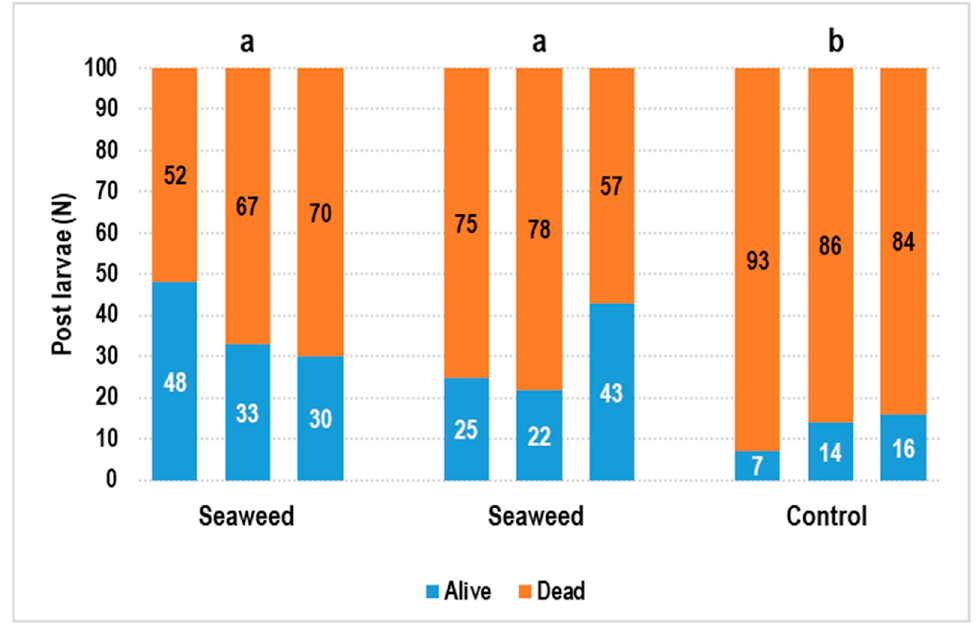
Figure 1. Panulirus homarus shelter experiment. In the shelter groups (seaweed and cotton filter), the survival rate was significantly higher than in the control group ( a,b p < 0.05).